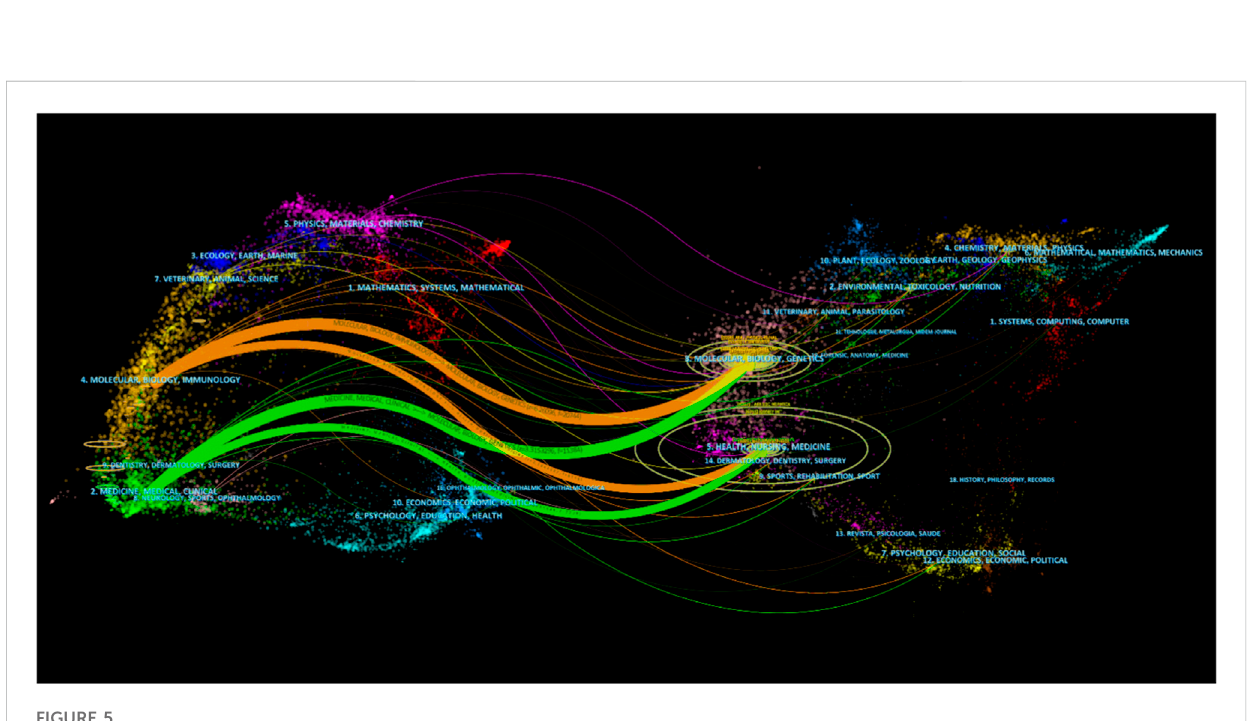
FIGURE 5 Dual-map overlap of journals on kidney repair in AKI